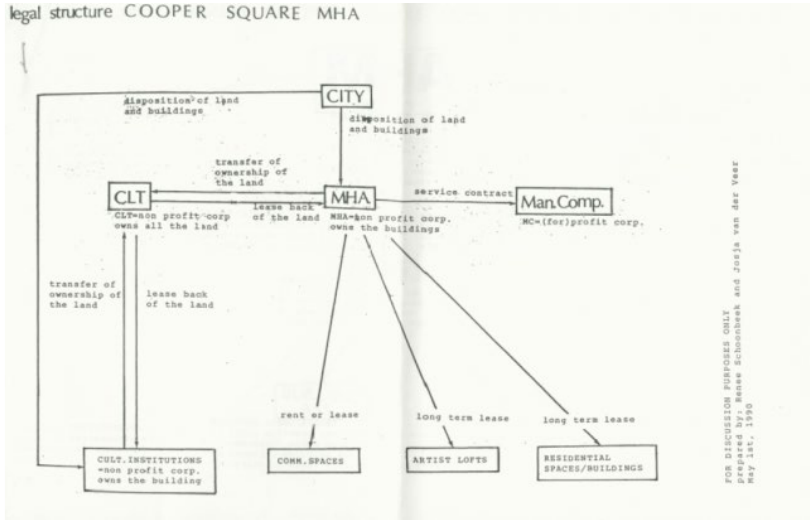
Figure 4. Illustrating officialdom, Cooper